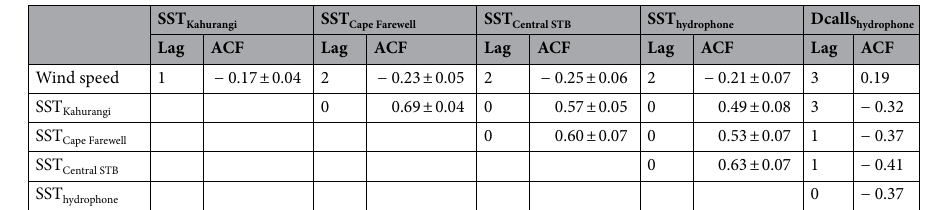
Table 1. Results from the cross-correlation analysis between timeseries data from the four focal boxes. Lag values are reported in weeks, and the autocorrelation function (ACF) measures the strength of the correlation (between − 1 and 1) between timeseries at that lag value. Cross-correlations were run for the months of October–March for each year between 2010 and 2018, and ACF values are reported as the mean and standard error for all cross-correlations. D call density was only recorded in one year (October 2016–March 2017), so cross-correlation results are only reported for that year.